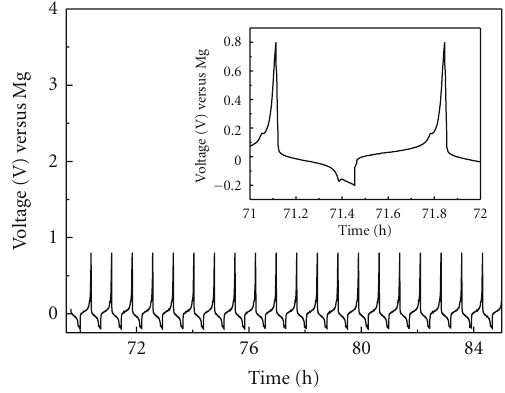
Figure 9: Typical galvanostatic cycling curves for Mg deposition- dissolution on Cu substrate in 0.3 molL − 1 Mg(CF 3 SO 3 ) 2 /BMImBF 4 + THF (3: 1) inset shows one of the cycle curves. The counter electrode is magnesium powder